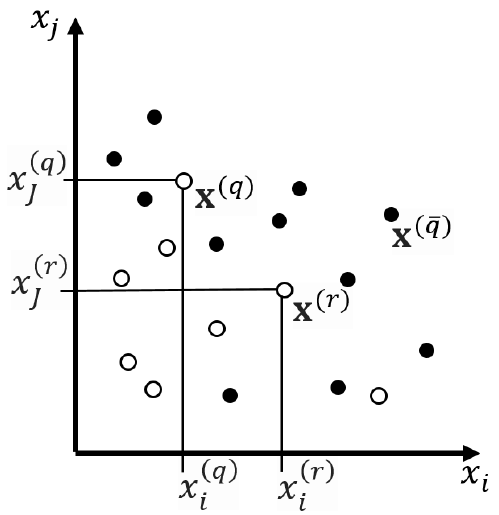
Figure 2. Space of features, sample points of classes, and orthants. White dots correspond to class ω 1 , and black dots correspond to class ω 2 . The rule corresponds to the disjunction of two conjunctions: ( q ) ( r ) ( r ) ) OR ( x ≤ x ( q ) ) THEN the point x belongs to class ω IF ( x i ≤ x AND x J ≤ x AND x J ≤ x i i j i j with probability U ( x ) = 7/8 and with probability V ( x ) = 2/12 belongs to class ω 2 . Due to the increase in the size of the orthants after correction, the probability of a false alarm may increase. If this result is unacceptable, then the number of orthants must